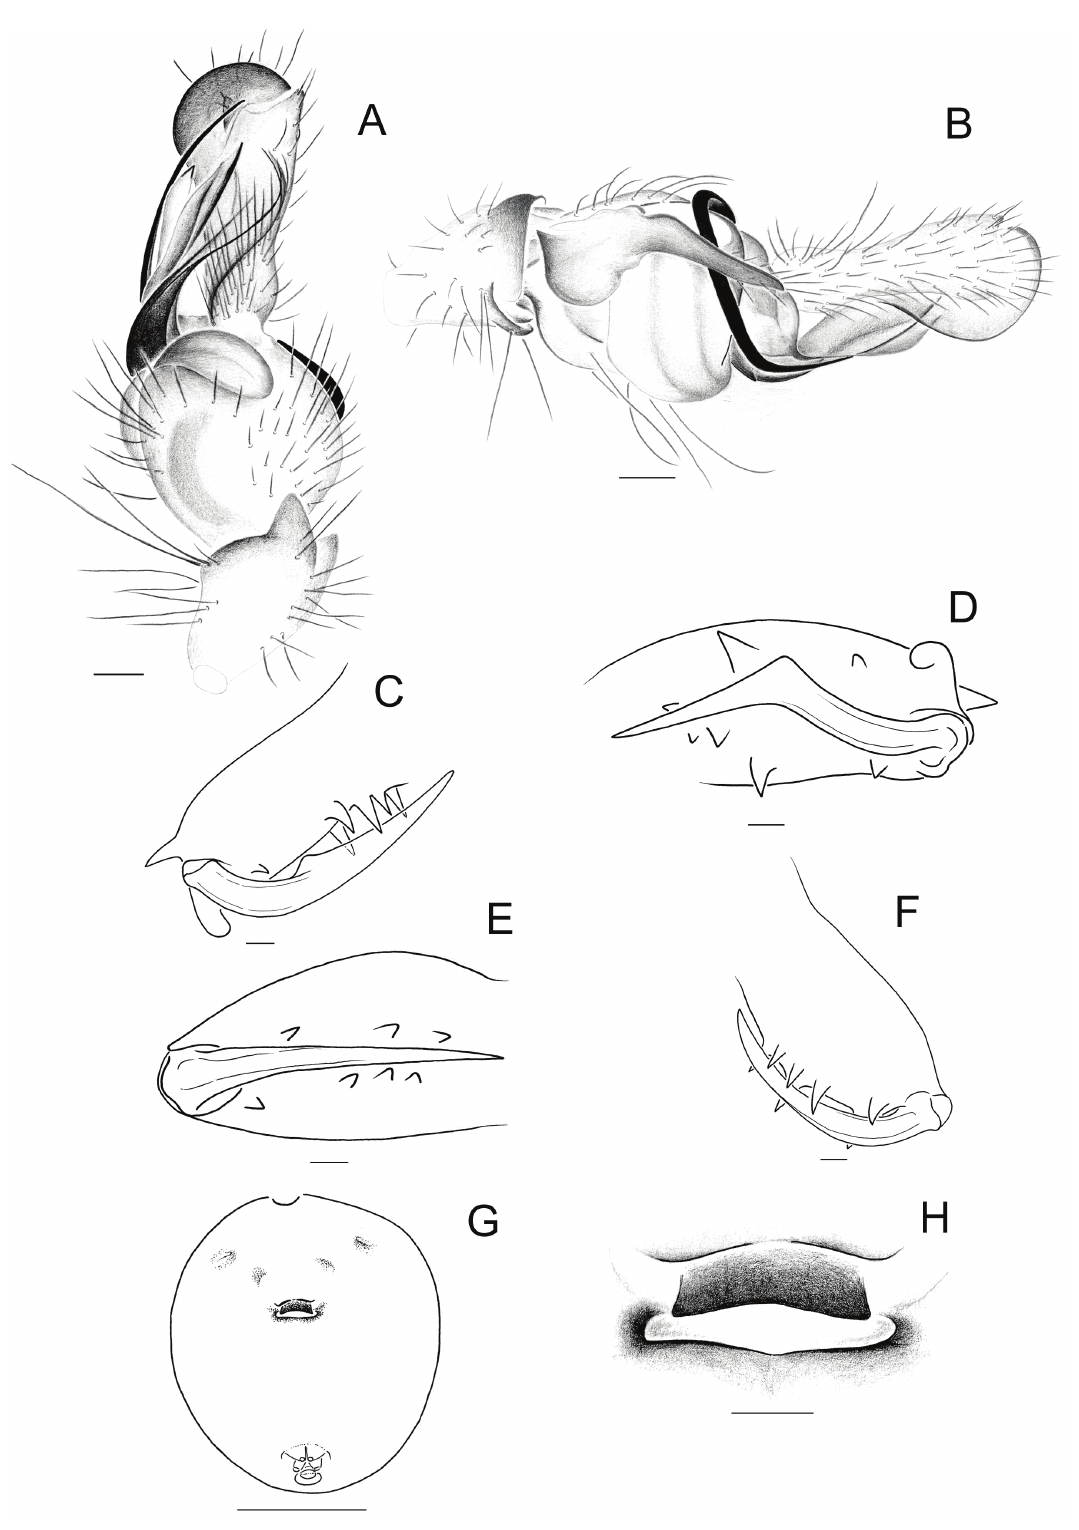
Fig. 4. Pachygnatha ventricosa sp. nov. A . Male palp, ventral view. B . Male palp, retrolateral view. C . Male chelicera, frontal view. D . Male chelicera, ventral view. E . Female chelicera, ventral view. F . Female chelicera, frontal view. G . Female abdomen, ventral view. H . Female external genitalia, ventral view. Scale bars: aF, h = 0.1 mm; g = 1